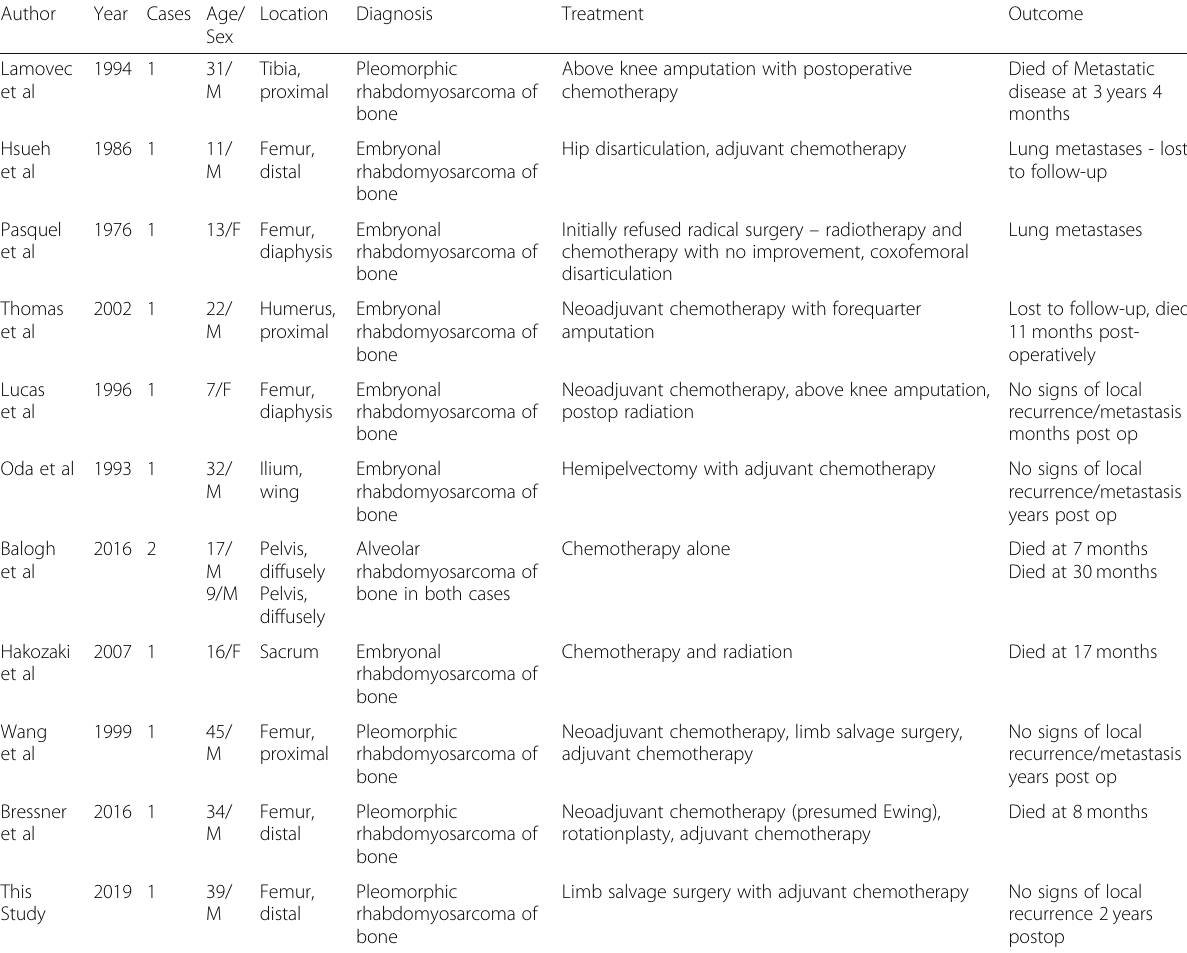
Table 1 Reported cases of rhabdomyosarcoma of bone in the literature including treatment and outcomes